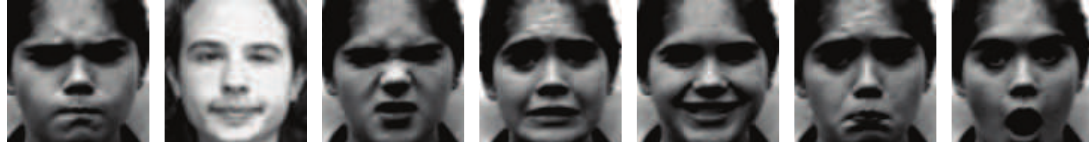
Figure 11. Examples of images in the CK+ database. The emotions from left to right are: anger, contempt, disgust, fear, happy, sadness, and surprise.